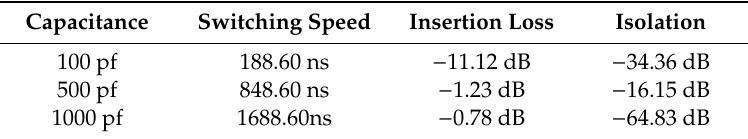
Table 2. Performance comparison of FET switches by 10MHz